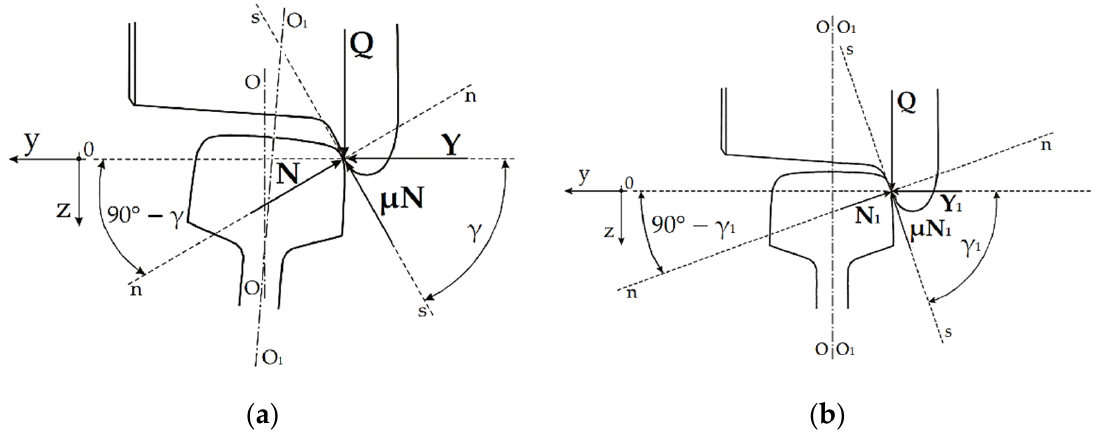
Figure 4. Dependence of the function ( Y/Q ) on the coefficient of friction μ and the flange angle γ according to UIC 518.